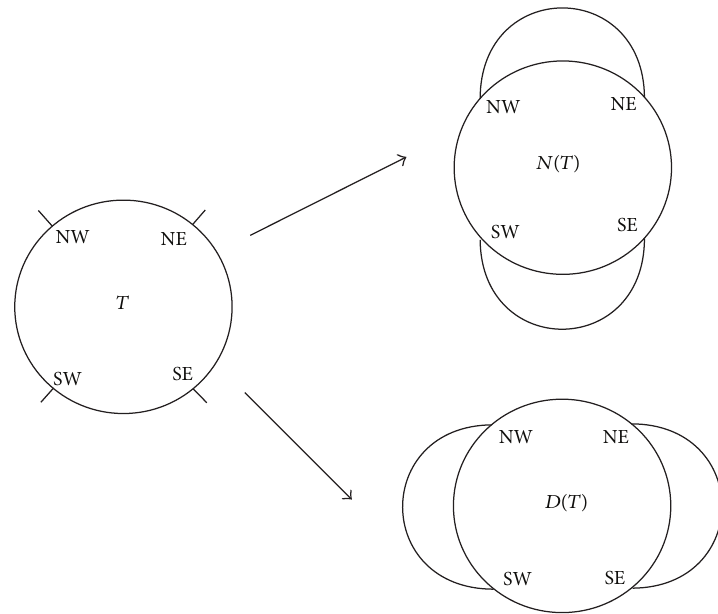
Figure 8: The numerator closure and denominator closure of